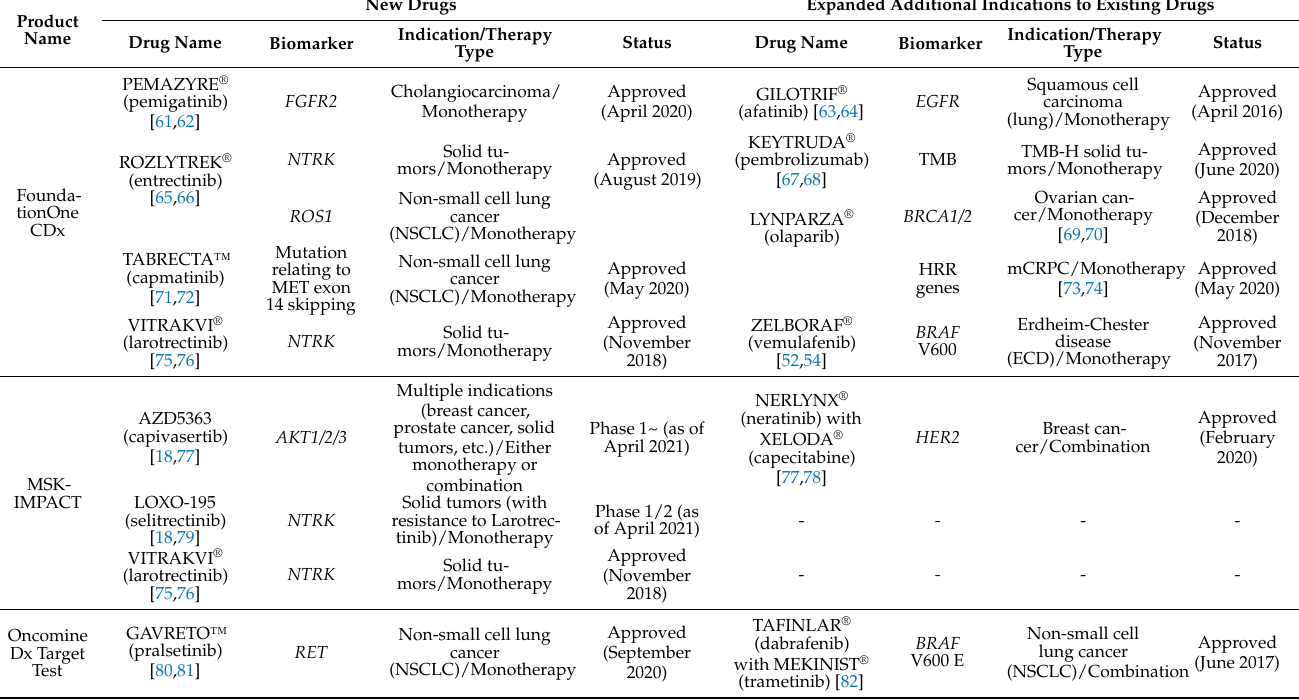
Table 3. Comparison of